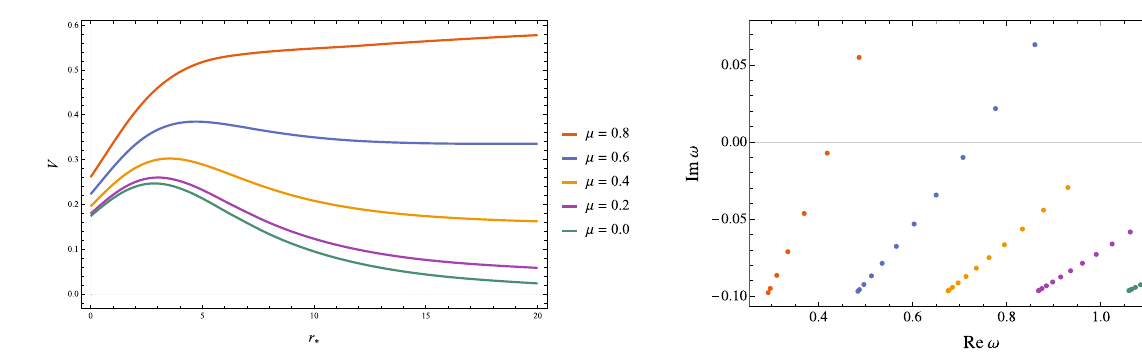
Fig. 4 The QNF spectrum of the extra-dimensional scalar field whose higher-dimensional contribution emerges as a mass-like term. We use the Dolan–Ottewill method to plot the imaginary components against the real for μ ∈ { 0 , 1 } . Note that even for these small multipolar num- bers, the range of the QNF decreases for increasing